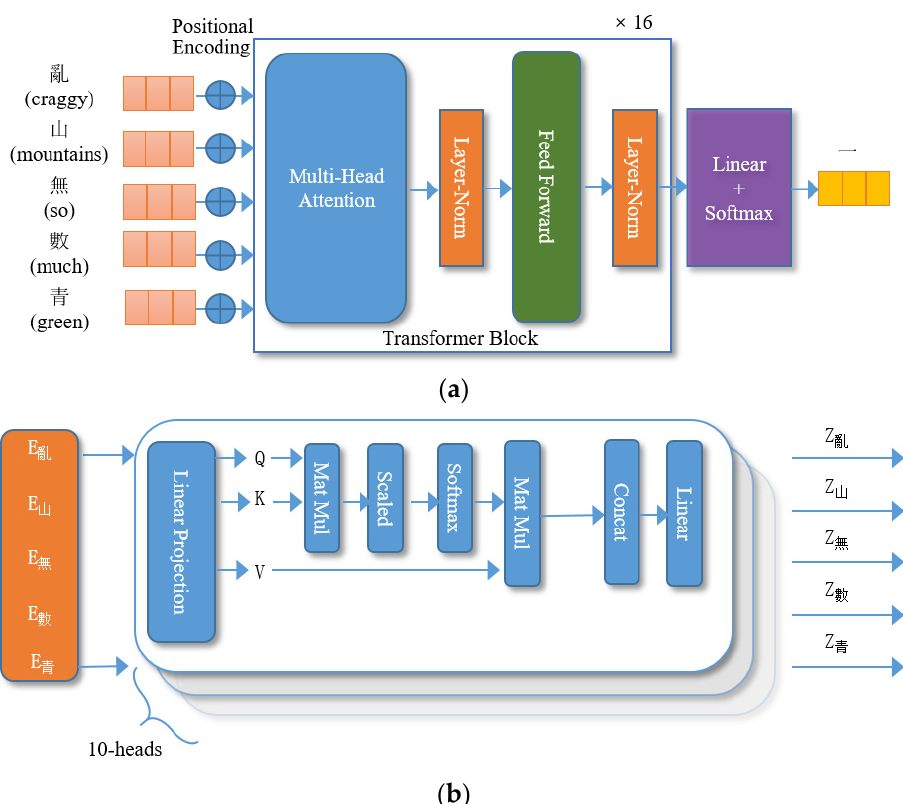
Figure 2. The classical Chinese poetry generation model based on Transformer-XL (CCPTXL): ( a ) The classical Chinese poetry generation model and ( b ) Multi-Head Attention Layer.